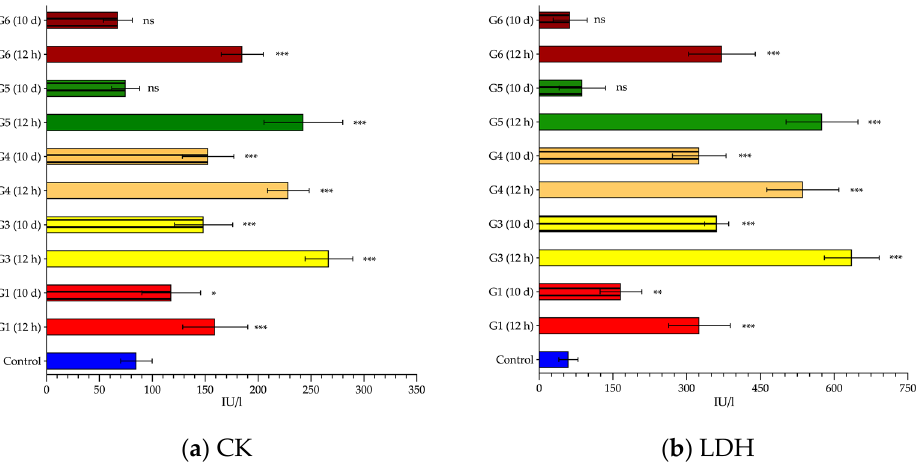
Figure 5. Serum values of ubiquitous enzymes. Creatine kinase (CK) ( a ), lactate dehydrogenase (LDH) ( b ) mean values (and standard deviation) measured in blood samples collected 12 h (smooth pattern) or 10 days (striped pattern) from control (blue) or alternating magnetic field (AMF)-exposed rats: 14 kA/m and 591 kHz (G1, red); 16 kA/m and 591 kHz (G3, yellow); 13.7 kA/m and 700 kHz (G4, orange); 14.4 kA/m and 774 kHz (G5, green); 11.2 kA/m and 856 kHz (G6, garnet). Values are expressed in international units per liter (IU/L). Statistical significance is shown compared to the control group values (*: p < 0.05; **: p < 0.01; ***: p < 0.001; ns: p > 0.05).